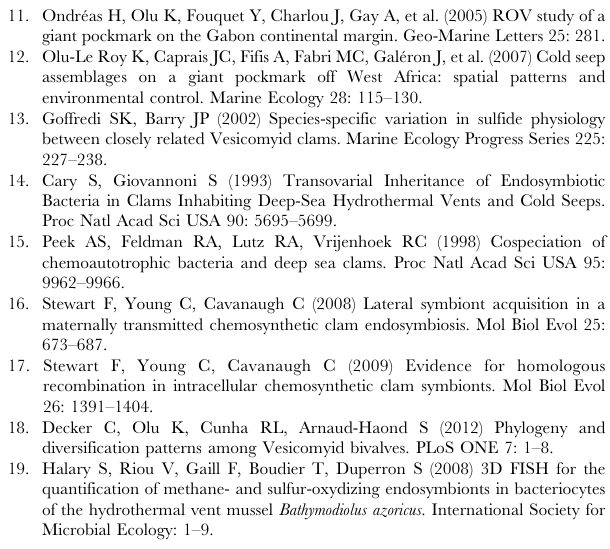
Figure S1 DNA maximum-likelihood tree on vesicomyid hosts based on coxI nucleotide sequences rooted with Venus antiqua , due to its close relationship with vesicomyids. The evolutionary model tested was GTR + I + G [30] (proportion of invariant sites = 0.48, number of substitution rates = 6, gamma distribution parame- ter =0.56). Bootstrap values for 1000 replicates are given in percent above branches and clades. Specimens are named according to recent species revisions. Scale bars are expressed as the number of substitutions per base pair. ‘Und. genus’) indicates a temporary genus name. Sp-1 to 10 correspond to species numbers given in Audzijonyte et al. 2012.